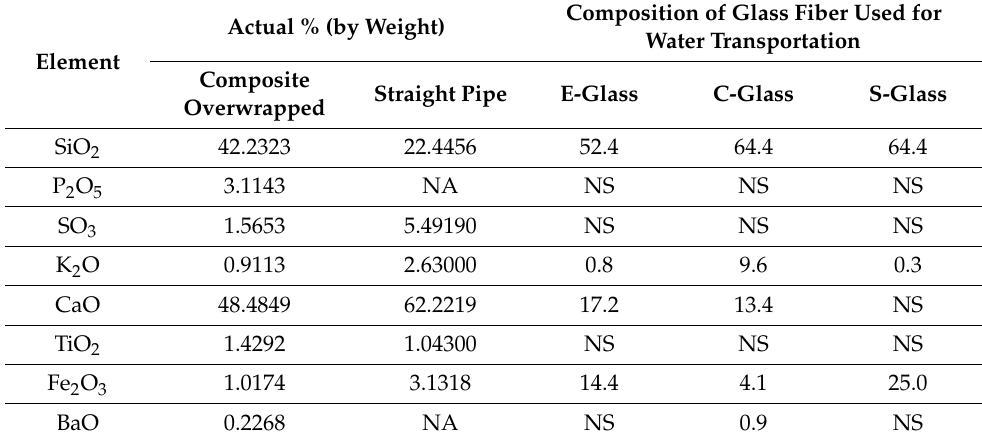
Table 2. Chemical analysis results of the composite elbow specimens.